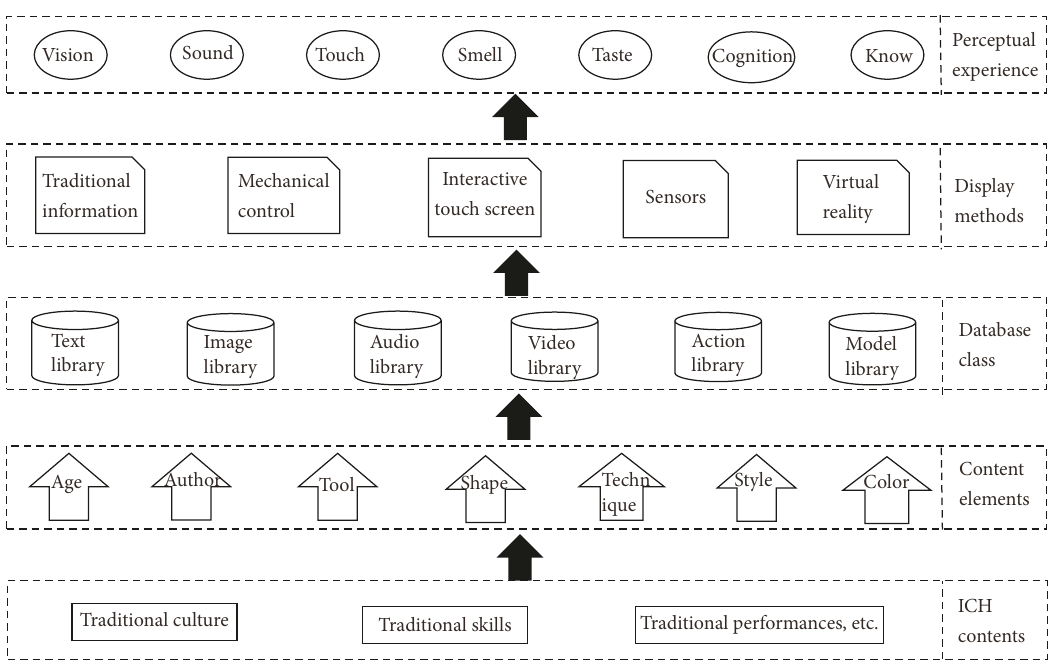
Figure 1: Flow of ICH digital